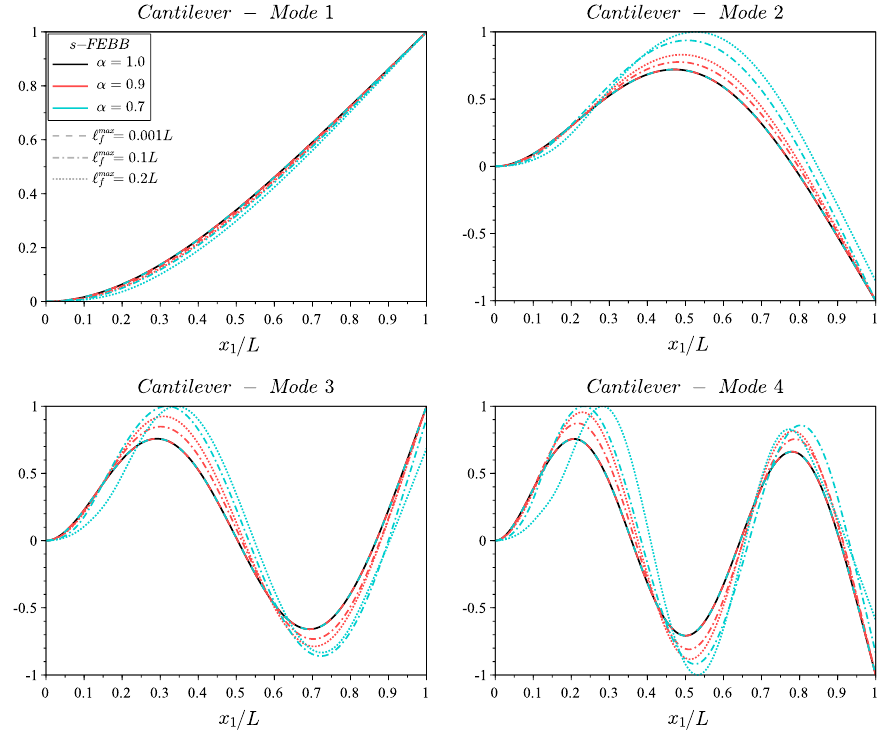
Figure 6. Shape of first four modes of cantilever beam for s-FEBB model with α = [ 0.9, 0.7 ] and (cid:96) max f